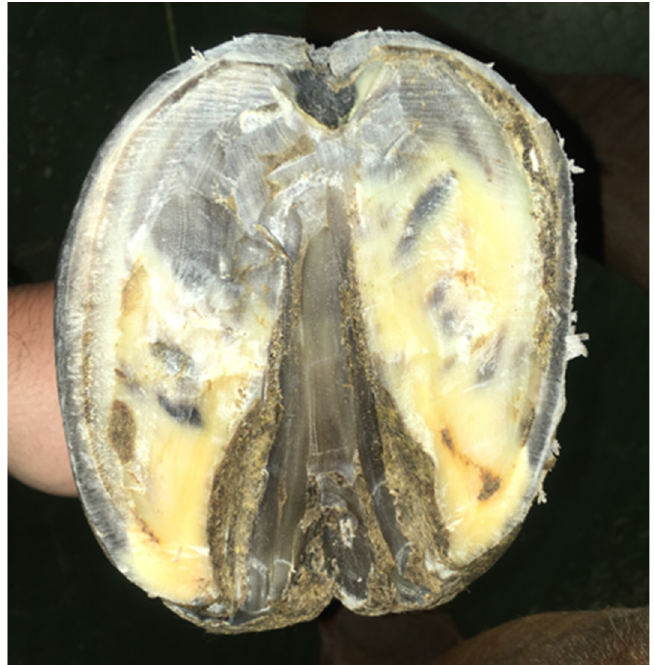
Figure 2. View of the superficially cleaned and trimmed sole of the foot, showing visible separation of the white line.